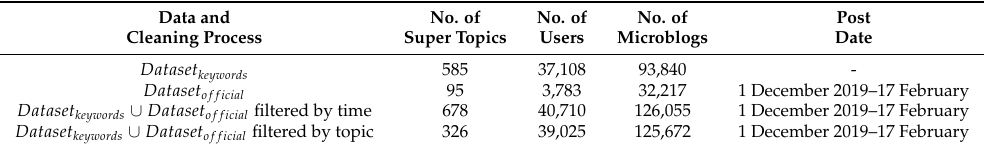
Table 2. Characteristics of the COVID-19-related microblog datasets and data cleaning processes.